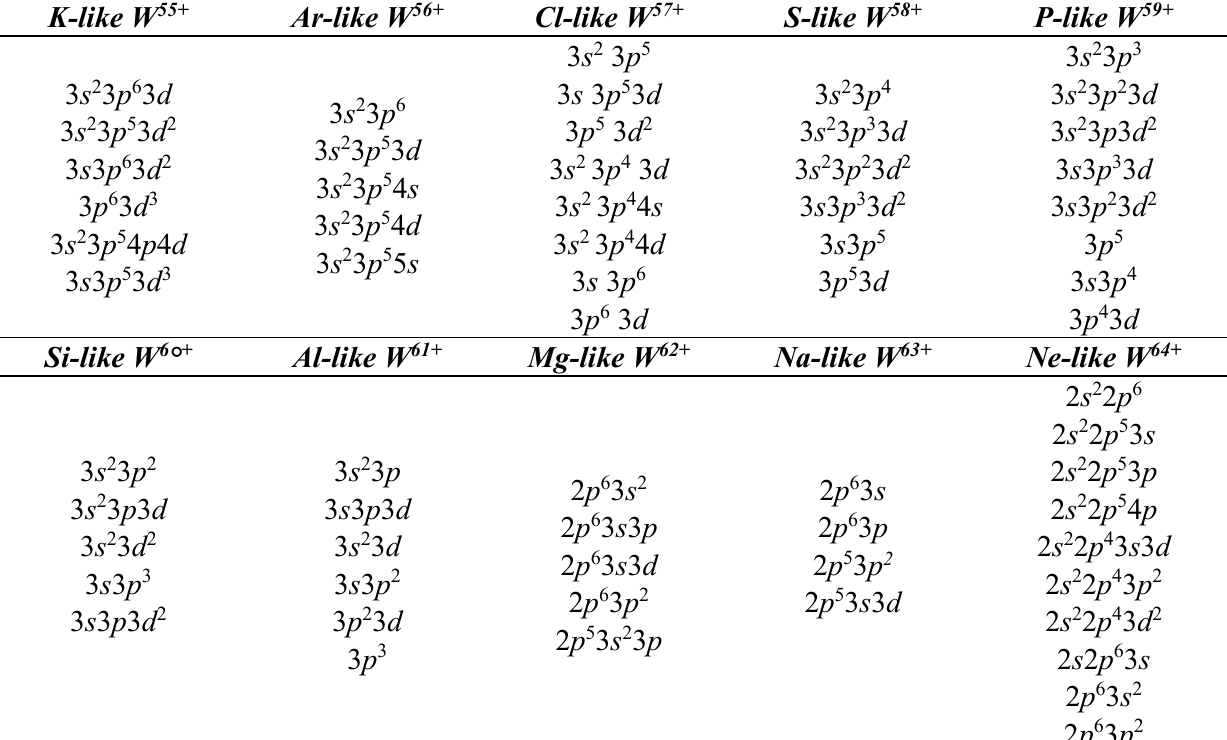
wavefunction for the initial and the final states in K-like W 55+ through Ne-like W 64+ ions. K-like W 55+ Ar-like W 56+ Cl-like W 57+ S-like W 58+ P-like W